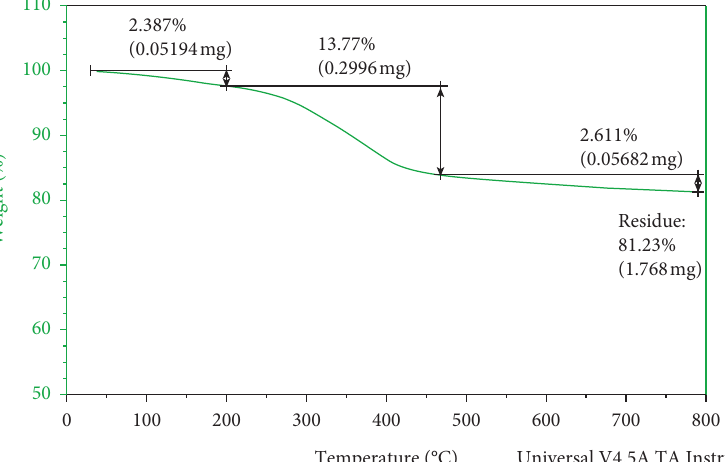
Figure 7: TGA analysis of TiO